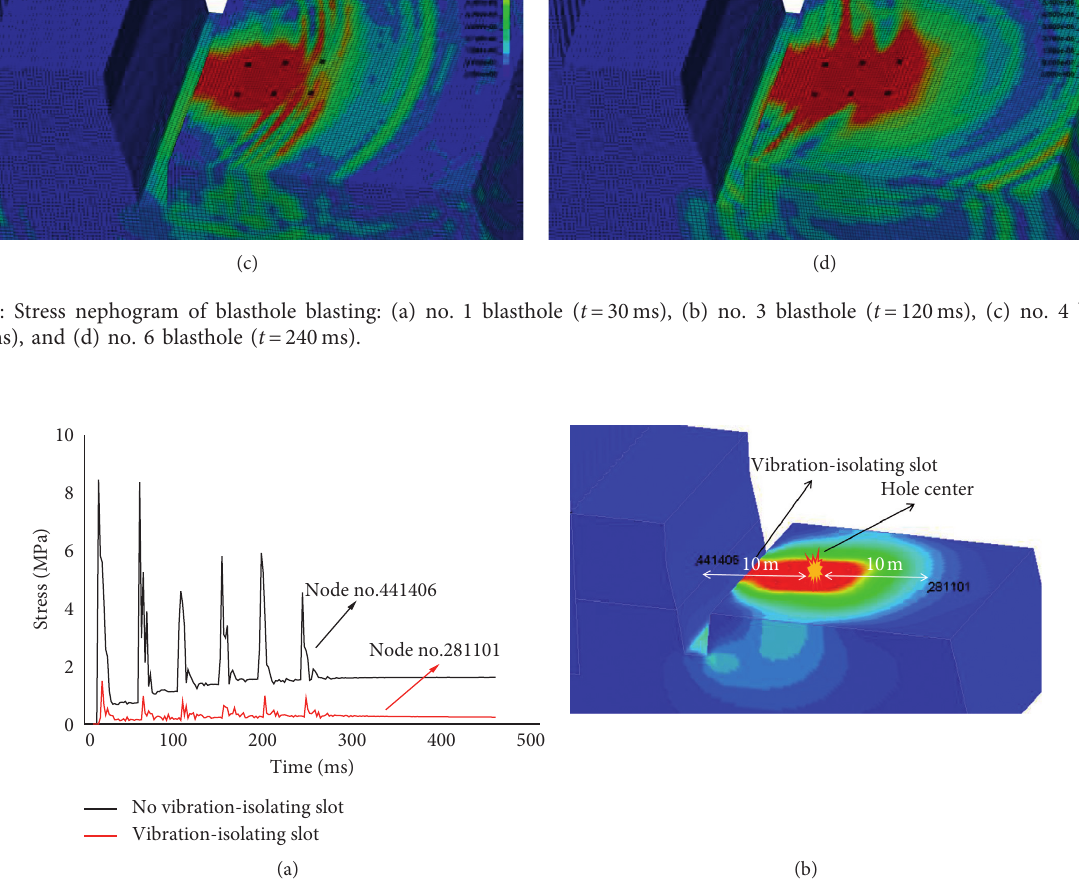
Figure 9: Stress comparison of characteristic points. (a) Stress vs. time curve; (b) the position of characteristic